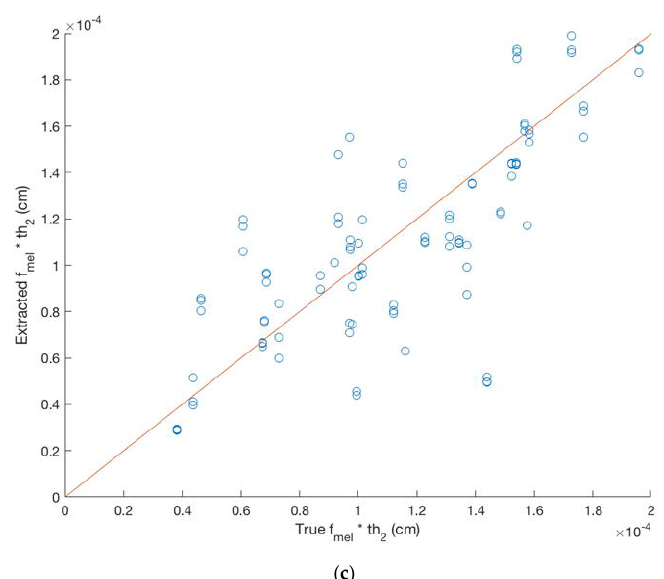
Figure 4. Comparisons between extracted values and true values of ( a ) f blood , ( b ) StO 2 , and ( c ) f mel × th 2 from 40 sets of simulated target spectra using fitting condition YA. The red lines indicate when the extracted and true values are identical.